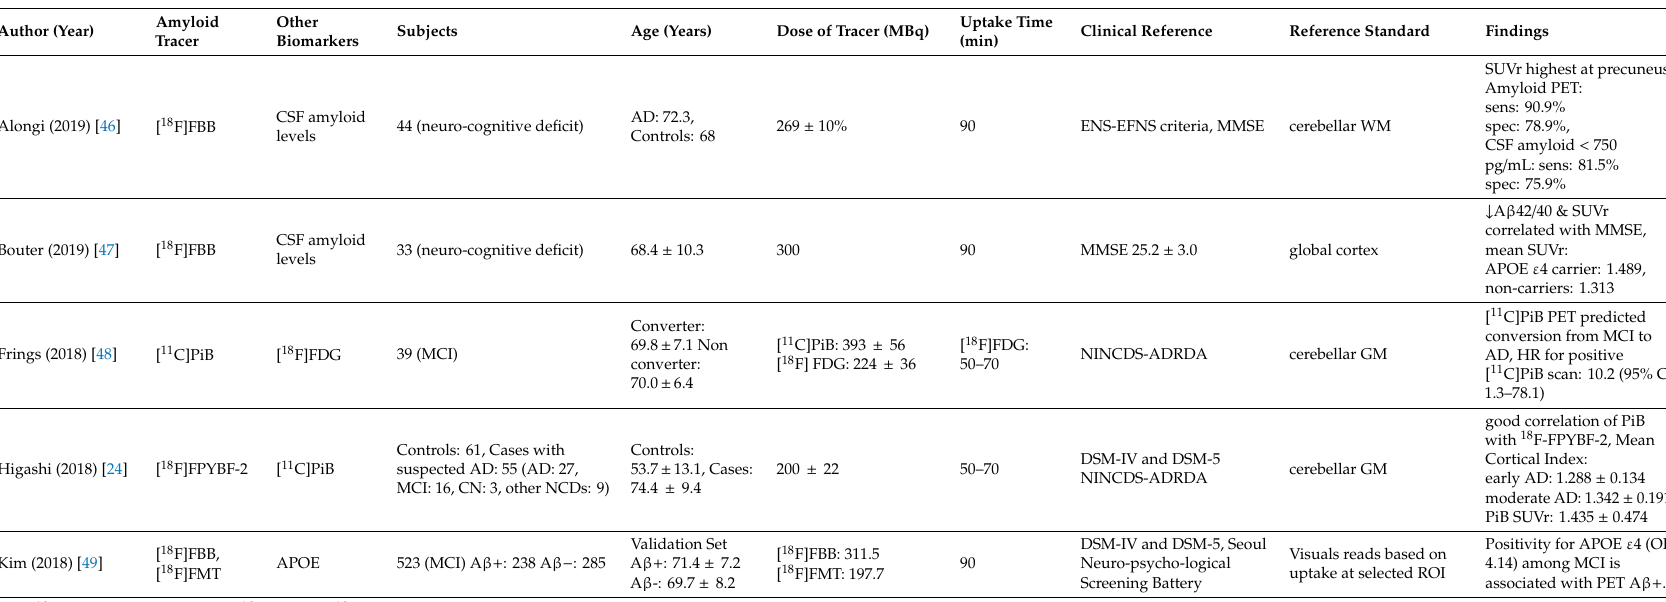
Table 2. Amyloid PET findings correlated with other biomarkers of AD and mild cognitive impairment (MCI).